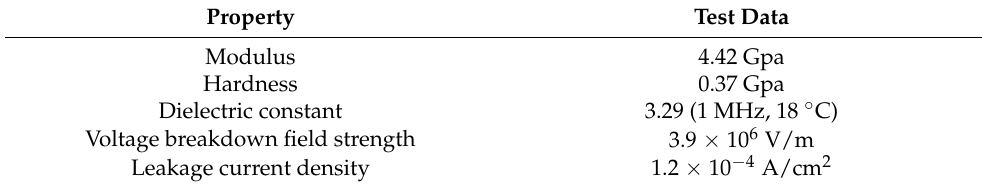
Table 1. Mechanical and electrical properties of the polyimide film.